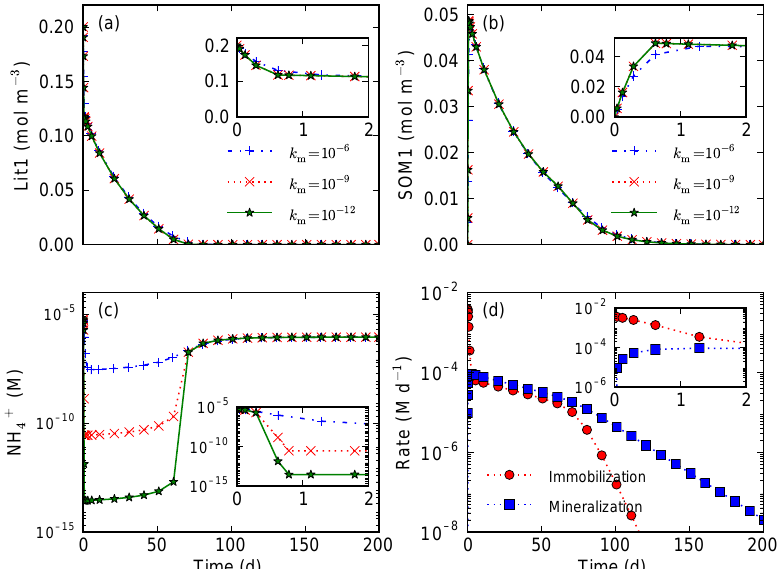
Figure 2. Influence of half saturation k m on decomposition that involves both nitrogen immobilization and mineralization. Smaller half saturation can result in lower nitrogen concentration (c) but does not substantially impact the calculated concentrations other than ammo- nium (a,b)